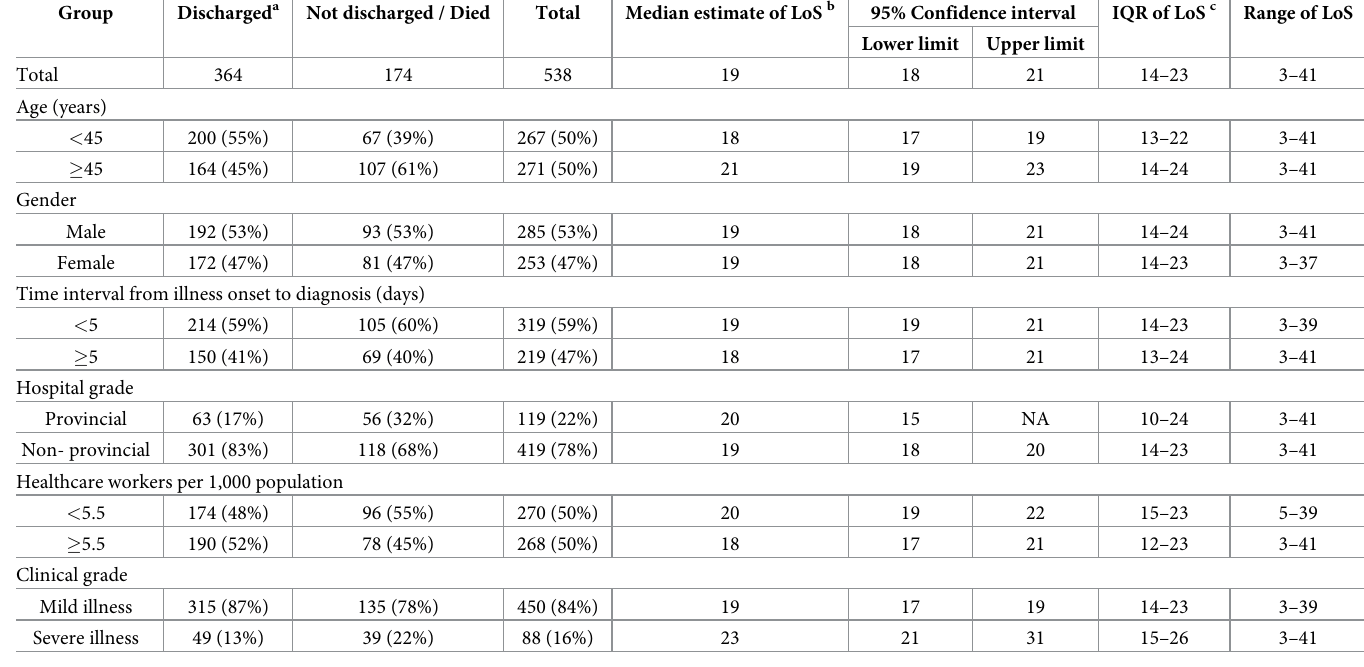
Table 1. Characteristics and LoS of 538 COVID-19 confirmed cases admitted to hospital.